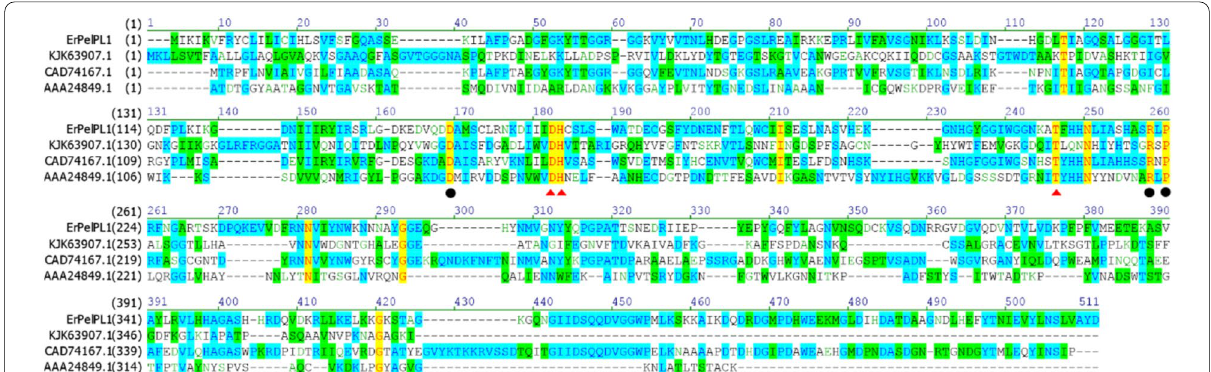
Fig. 2 Multiple sequences alignment of ErPelPL1 and partial pectate lyases from the PL1 family. Namely, PelC ( Erwinia chrysanthemii EC16, AAA24849.1), Pel ( Rhodopirellula baltica SH1, CAD74167.1) and ApPel1 ( Aspergillus parasiticus , KJK63907.1). The sequence alignment was performed by Vector-NTI. The three conserved residues coordinated with Ca 2 + are indicated by black dot. And the potential catalytic residues are marked with red triangle. Background colors represent different similarity: blue (conservative), green (block of similar) and yellow (identical),